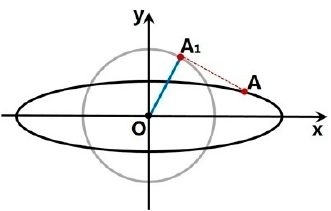
Figure 6. Different appearances of the circle in L 2 -metric distance and L 2 -metric distance with axial